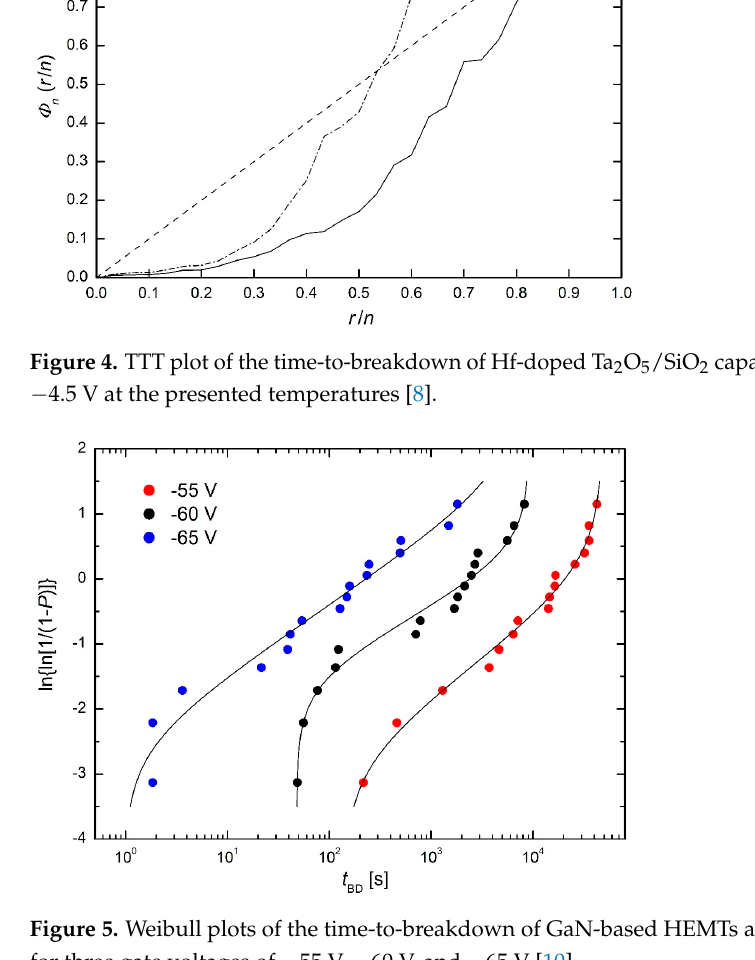
Figure 5. Weibull plots of the time-to-breakdown of GaN-based HEMTs at the temperature of 298 K for three gate voltages of − 55 V, − 60 V, and − 65 V